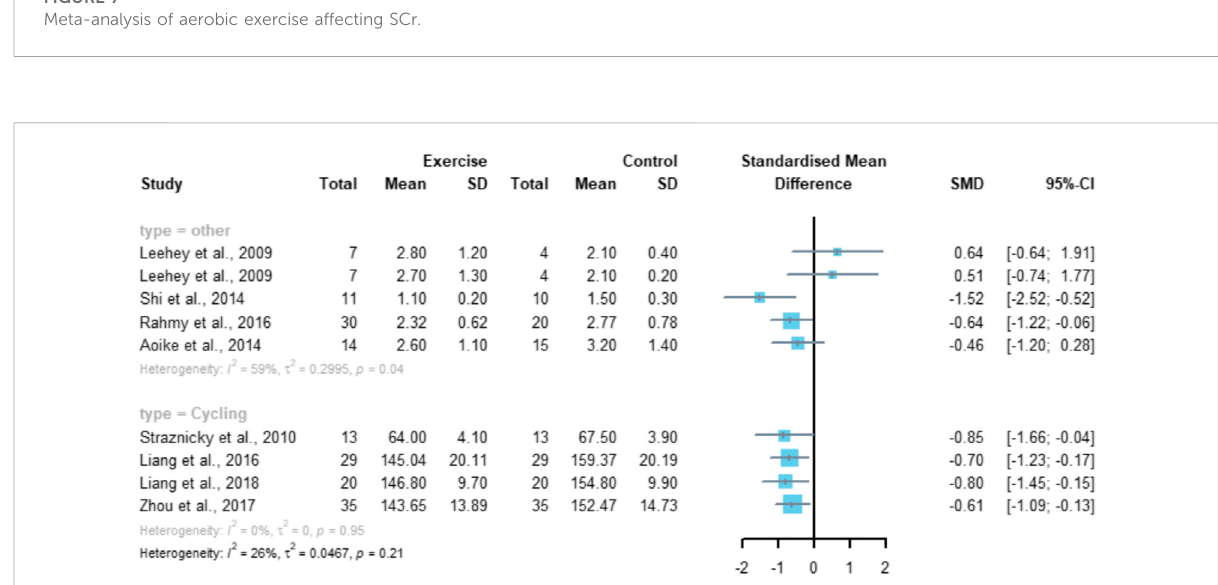
Subgroup analysis of the effect of aerobic exercise on